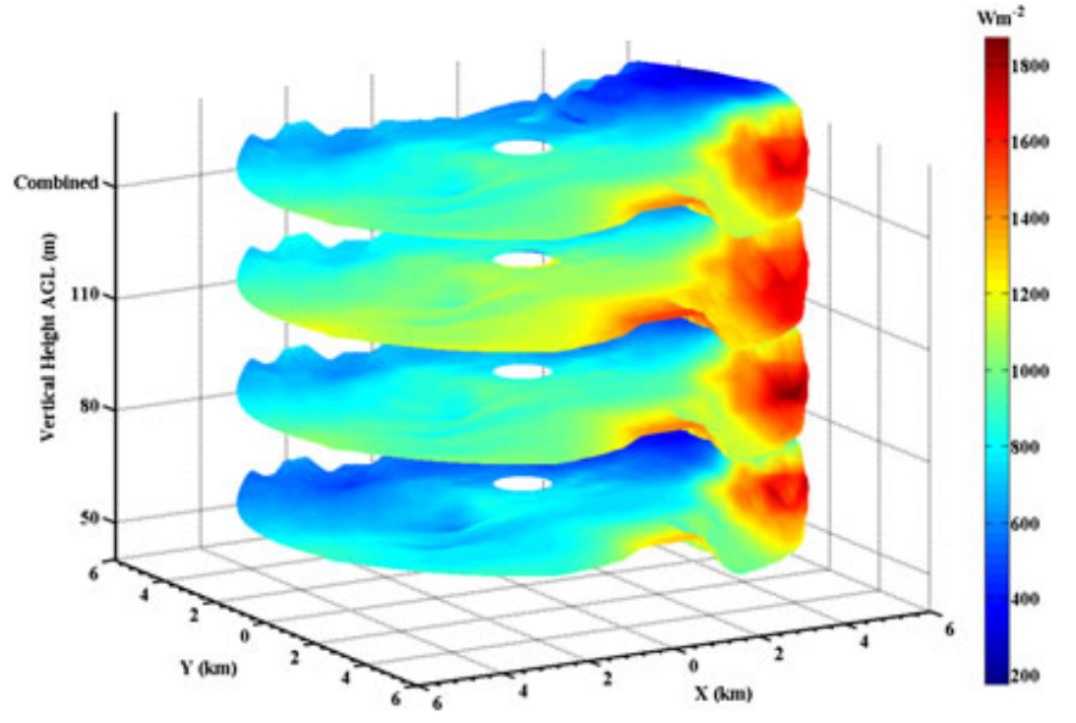
Figure 7. Estimates of wind power density at 50 m, 80 m and 110 m above the ground level and combined power density of these three layers. X (km) and Y (km) are the distances from lidar in the respective directions